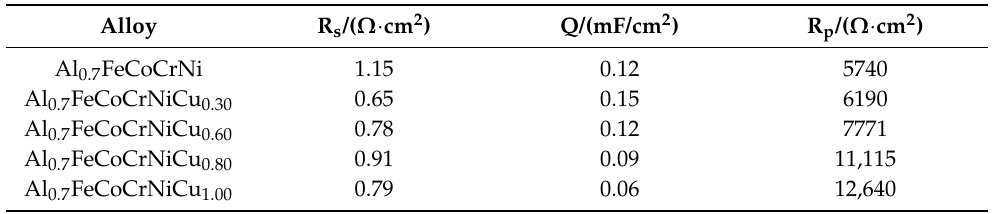
Table 7. AC impedance spectrum parameters of the Al 0.7 FeCoCrNiCu x high-entropy alloy in 3.5 wt.% NaCl solution.